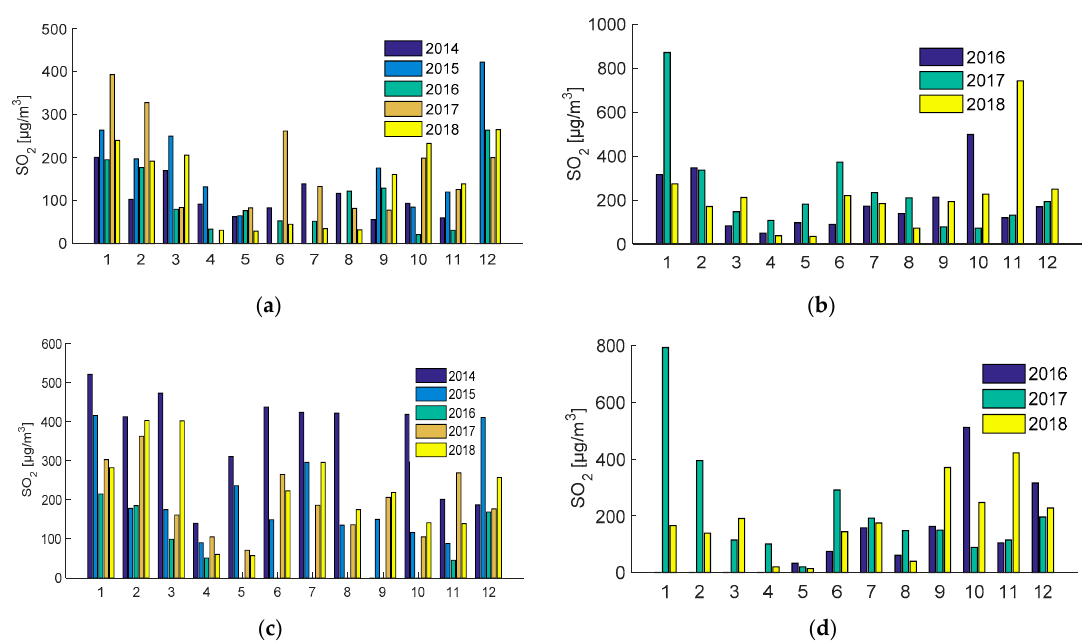
Figure 1. Maximum values per month of SO 2 pollutant ( a ) Otoka measuring station for 2014, 2015, 2016, 2017 and 2018 ( b ) Bjelava measuring station for 2016, 2017 and 2018 ( c ) Ilidža measuring station for 2014, 2015, 2016, 2017 and 2018 ( d ) City Hall measuring station for 2016, 2017 and 2018.